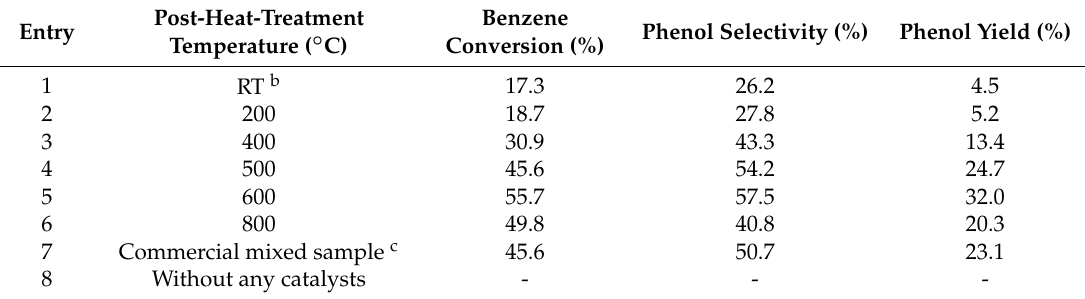
Table 3. Catalytic activity of the catalysts in the catalytic hydroxylation of benzene to phenol a .